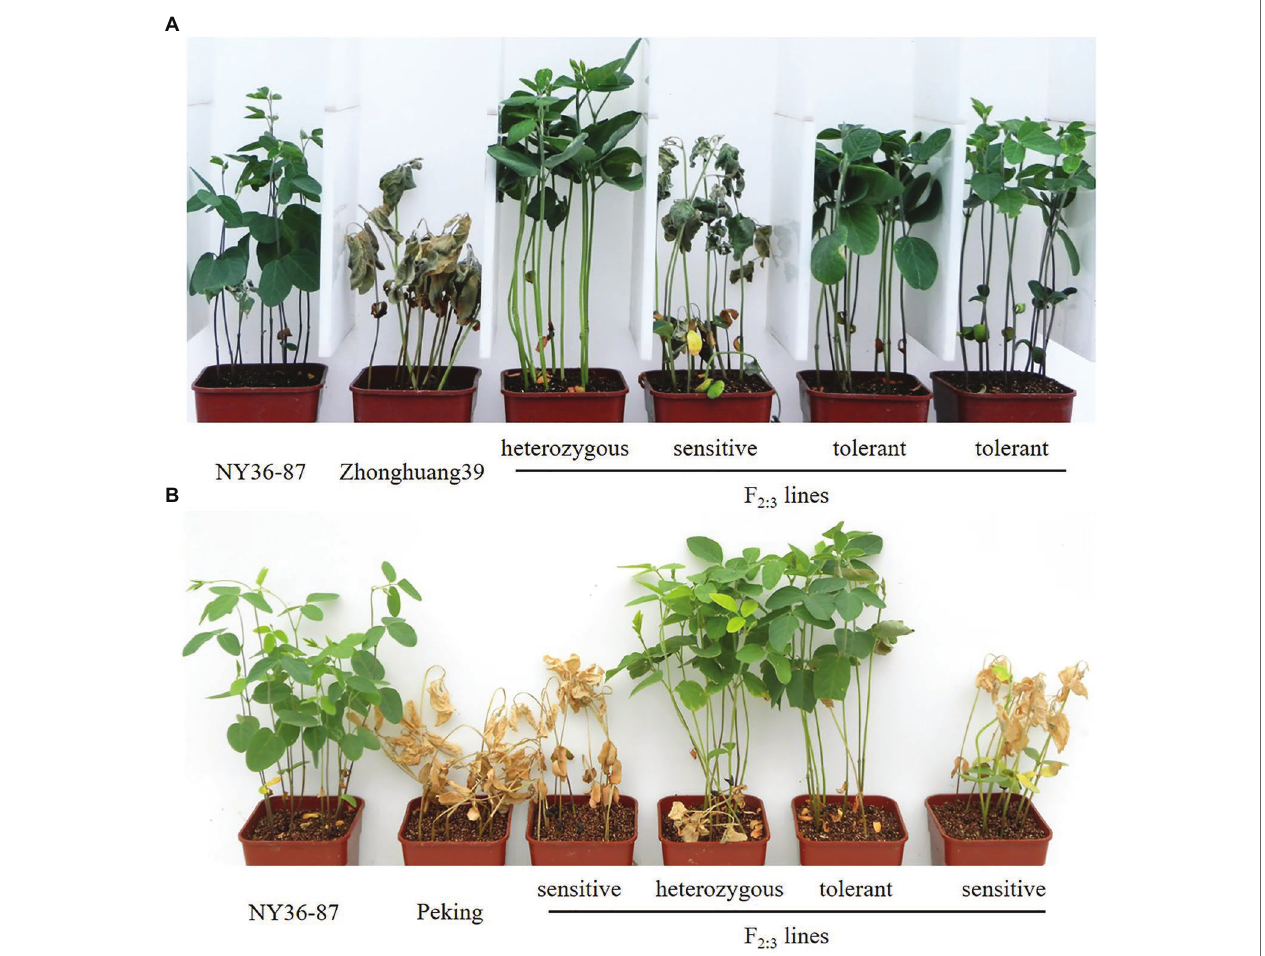
FIGURE 1 | Evaluation of salt tolerance based on leaf scorching in two F 2:3 populations. (A) Parents NY36-87, Zhonghuang39, and example F 2:3 families. (B) Parents NY36-87, Peking, and example F 2:3